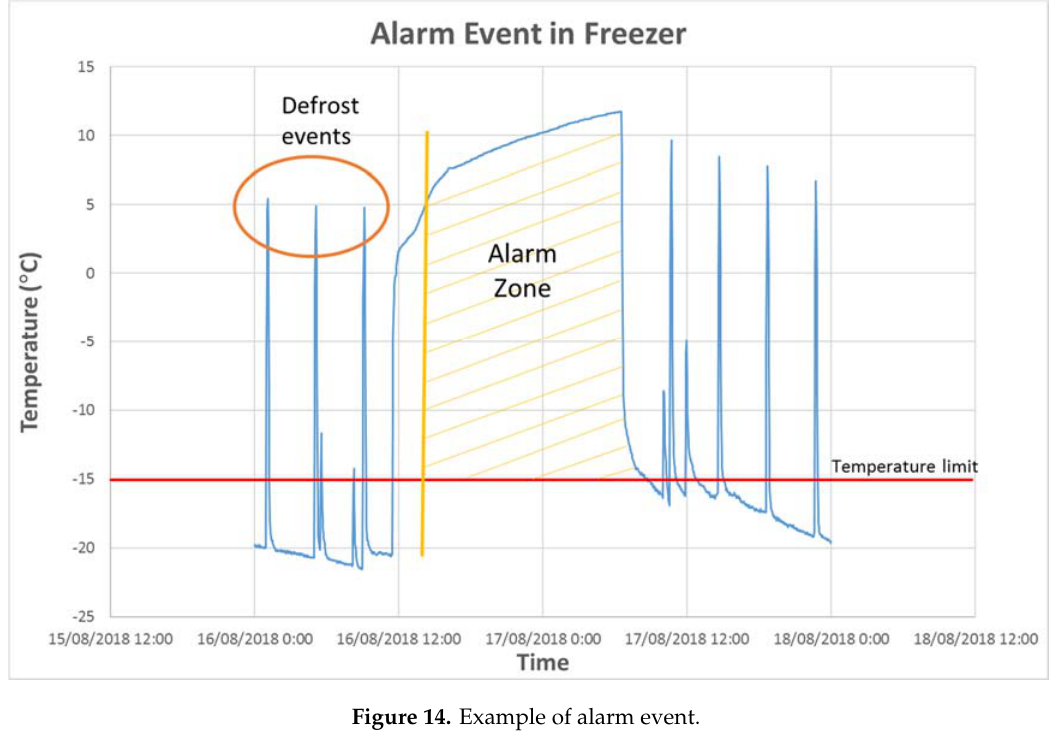
Figure 14. Example of alarm event.